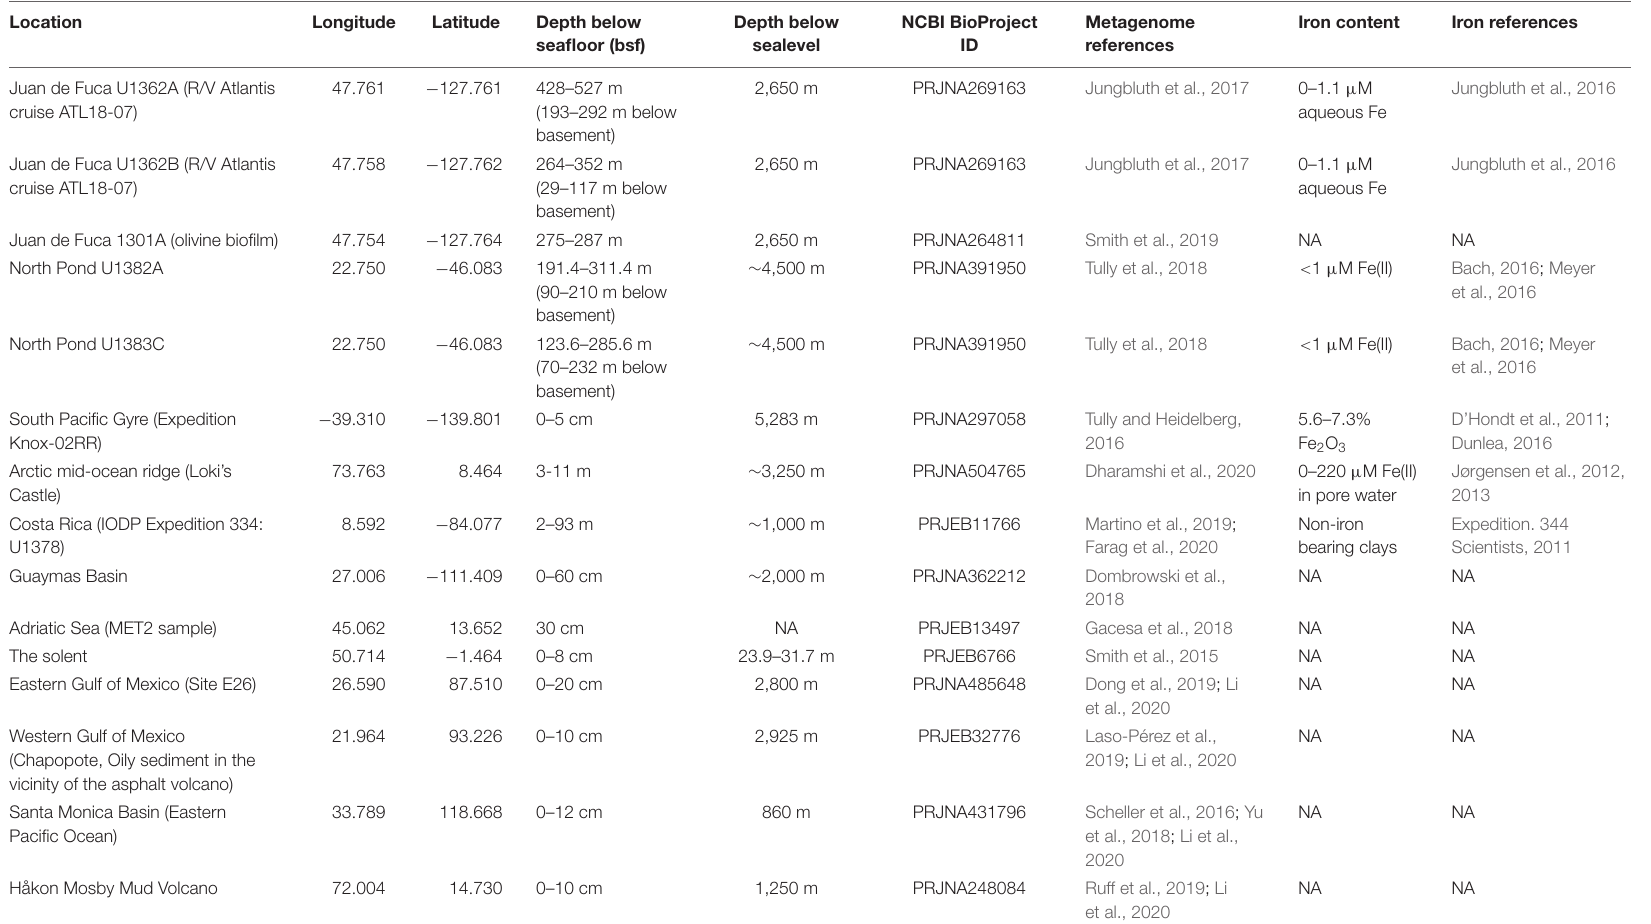
TABLE 1 | Metadata for metagenome samples in which iron redox genes were detected with FeGenie.